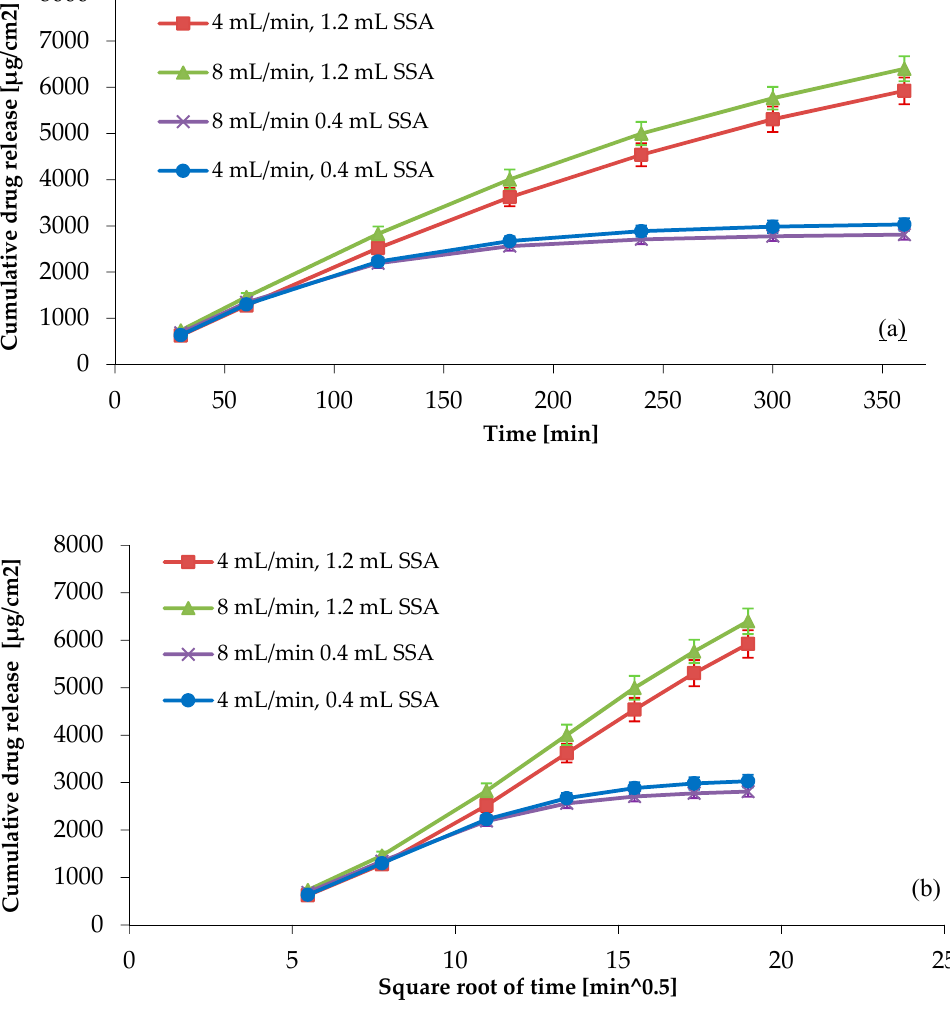
Figure 3. ( a ) Cumulative drug release per unit area in linear time scale, ( b ) cumulative drug release per unit area plotted against square root of time. Instrument: USP apparatus IV.